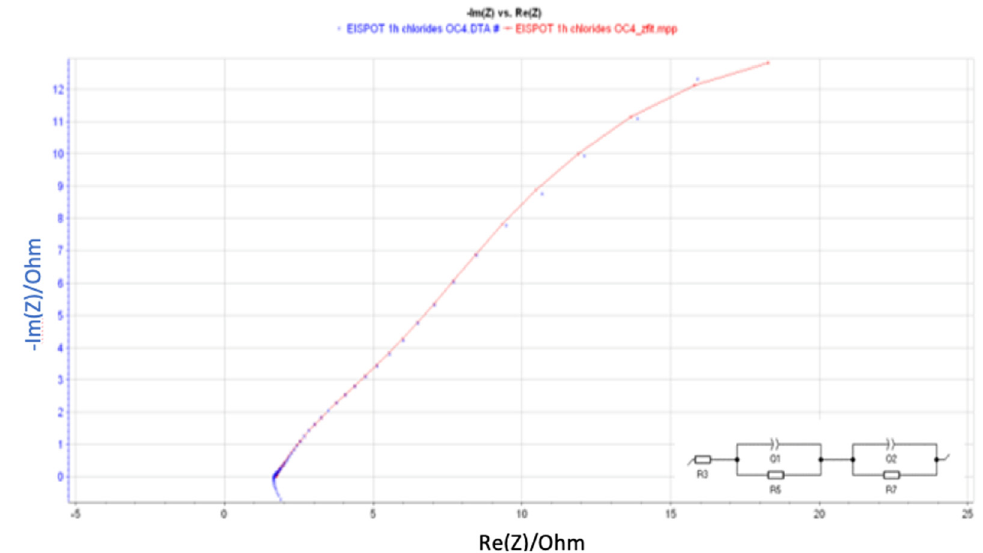
Figure 3. Nyquist diagram of OC4 immersed in ternary chloride molten salt for 1 h and fitting analysis to protective equivalent circuit analysis.